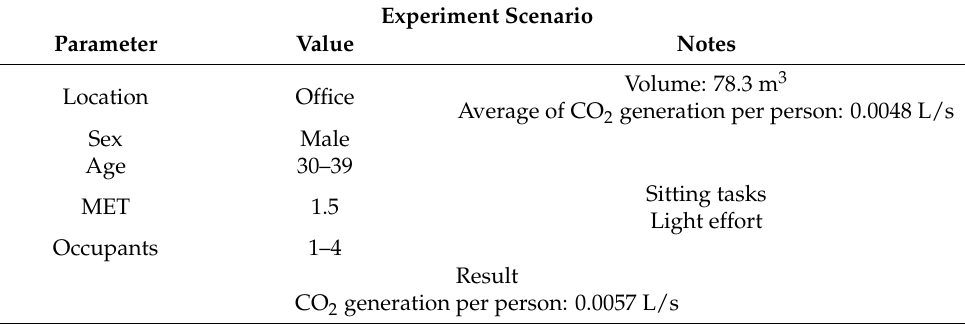
Table 6. Initial values for ventilation control algorithm.